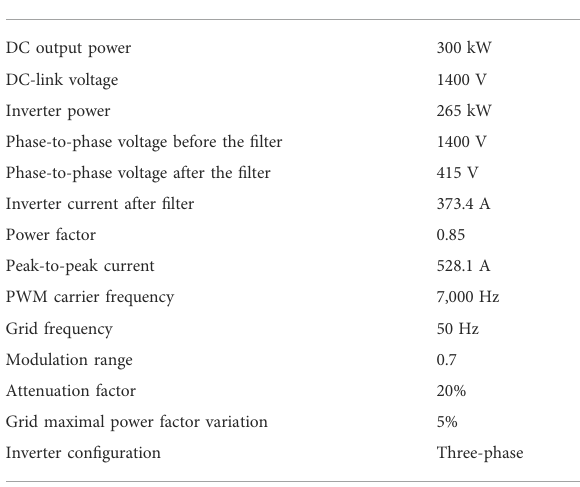
TABLE 4 Inverter design parameters.